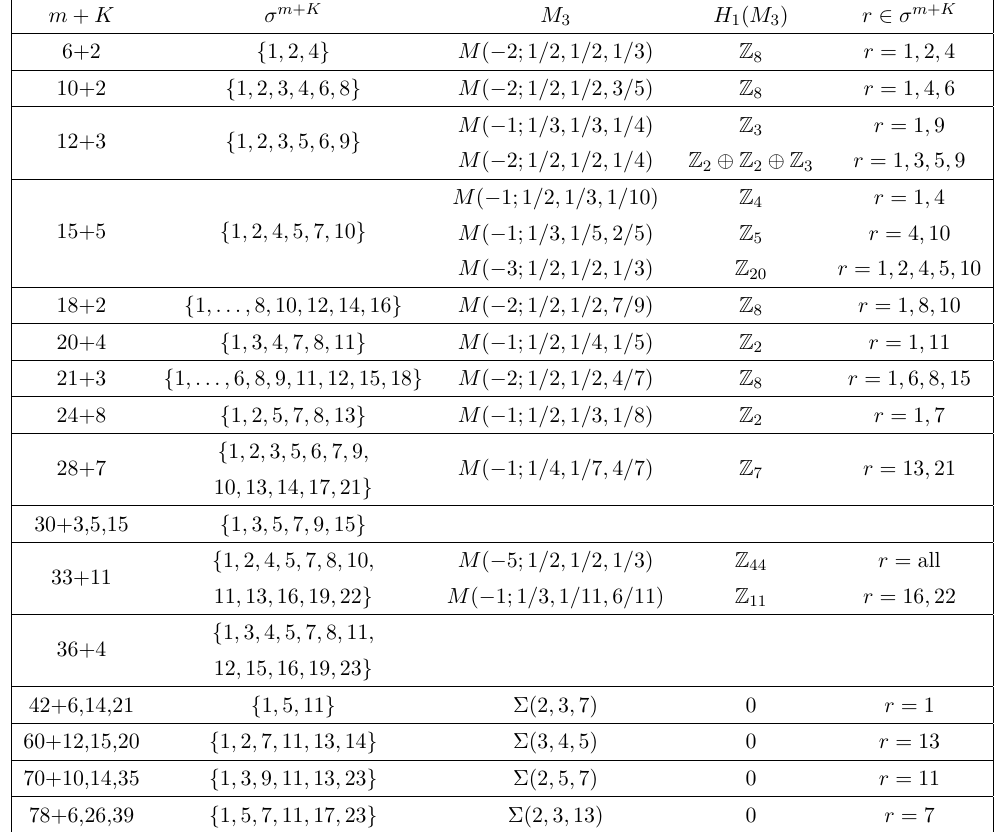
Table 14 . Optimal mock Jacobi thetas of non-Niemeier type and examples of the relevant 3-